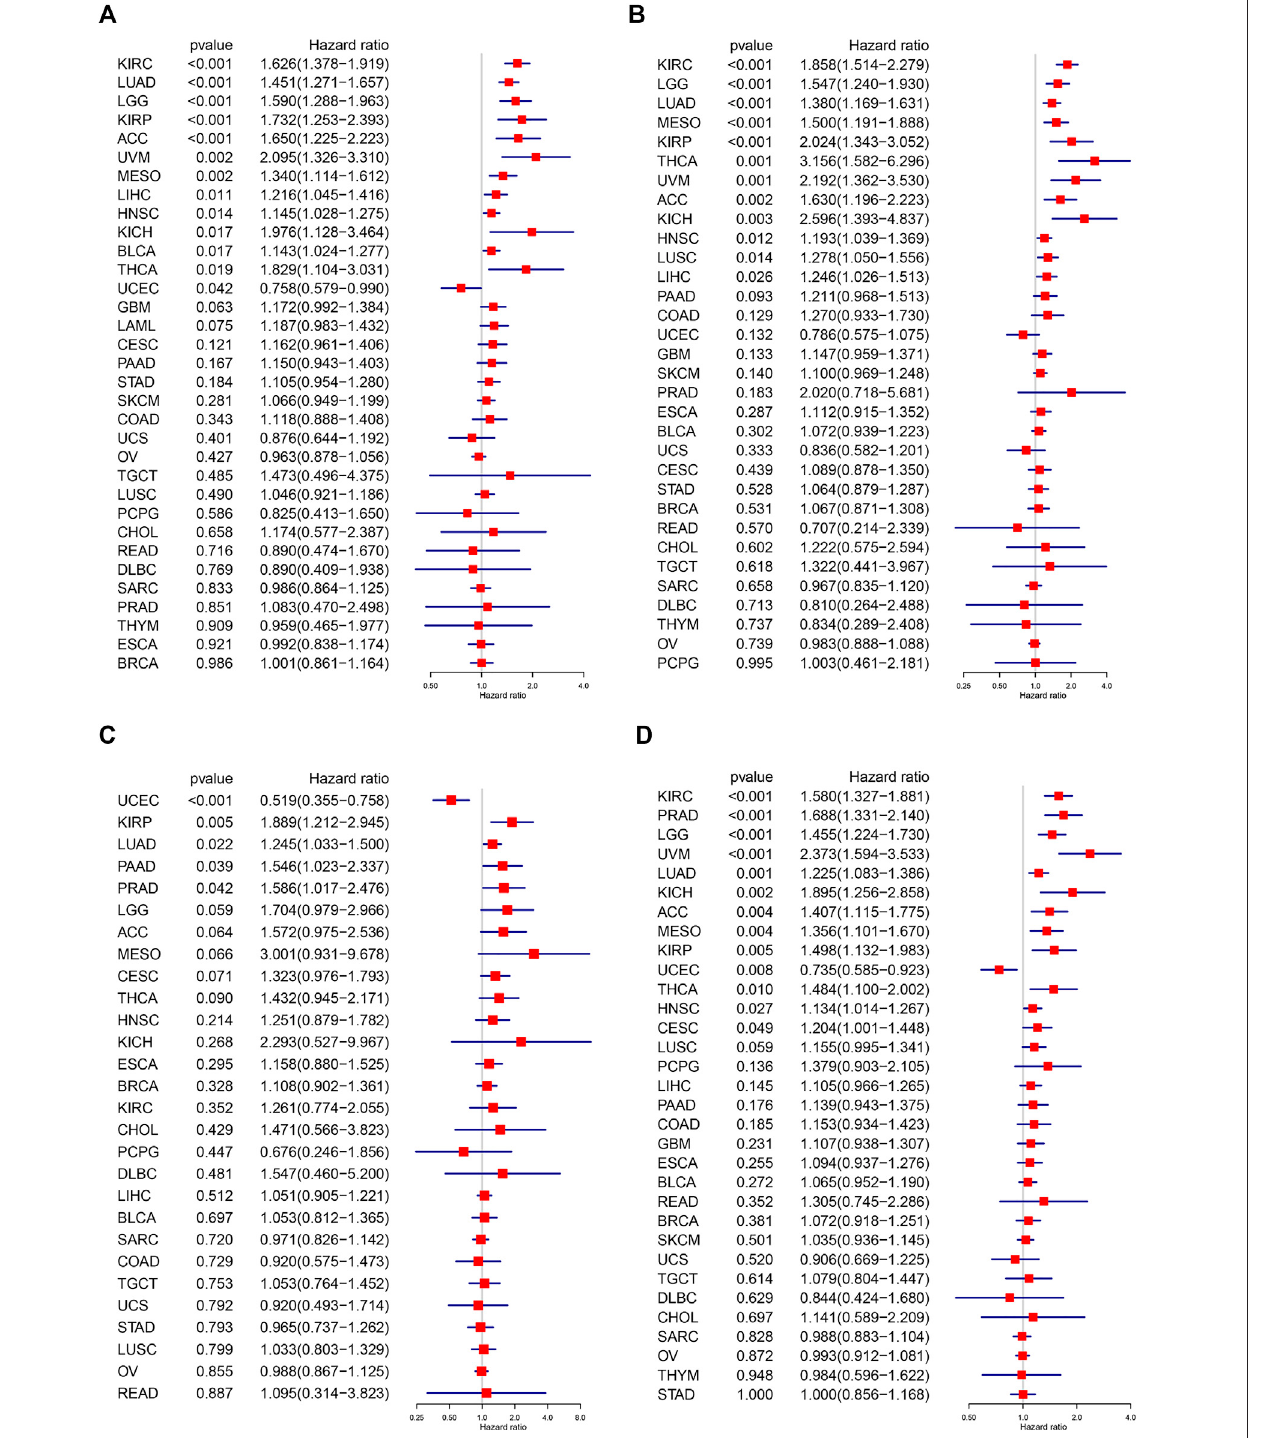
Figure 4 . C1QTNF6 gene expression was also signi fi cantly